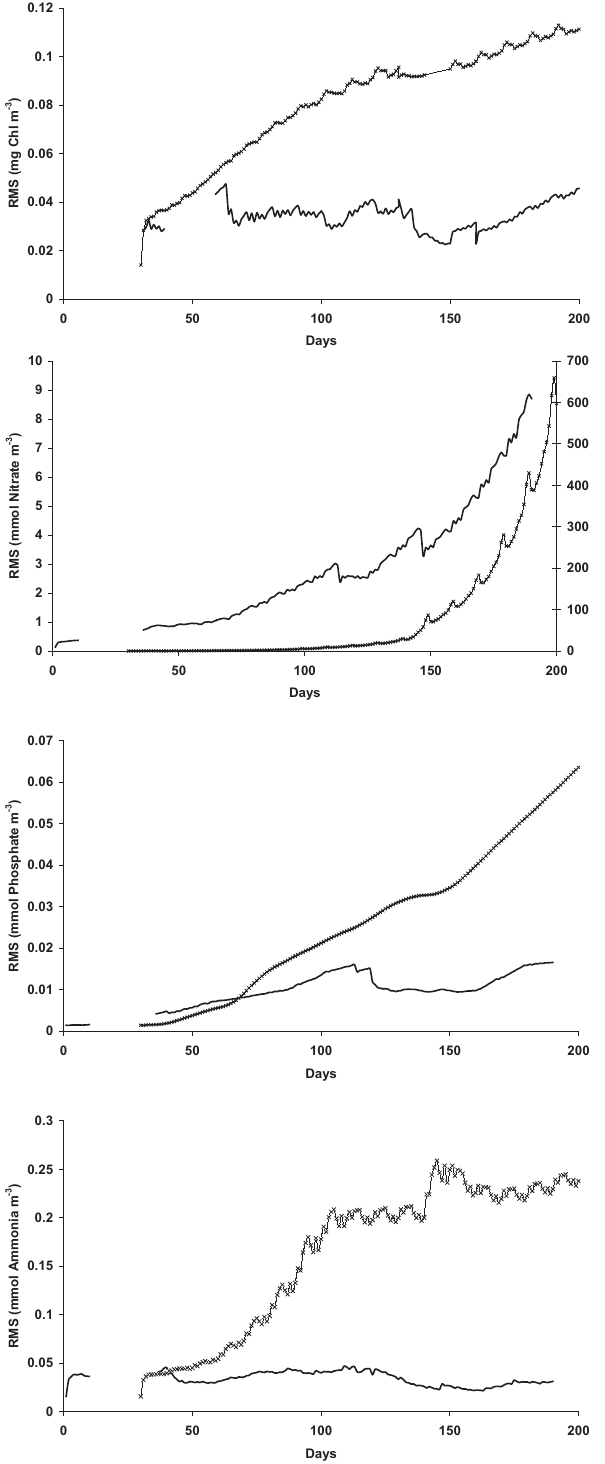
Fig. 7. Root mean square error for the ensemble climatology (x-x- x) and the 2-day EnKF assimilation ( ) for (a) chlorophyll, (b) nitrate, (c) phosphate and (d) ammonium. Nb, the scale for RMS for the nitrate climatology, is on the right side of graph b.